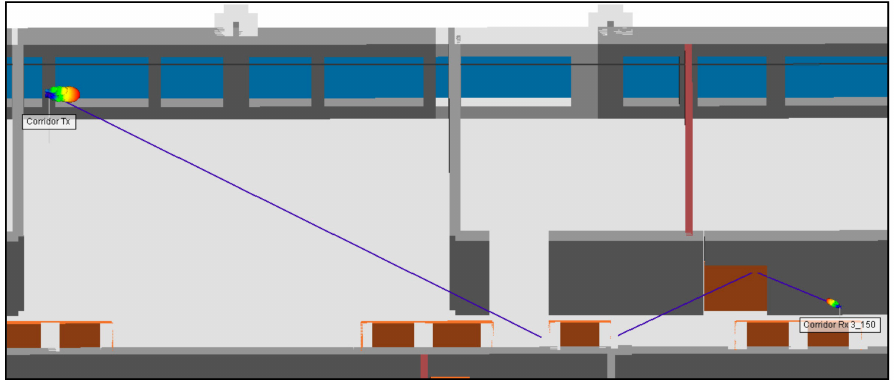
Figure 15. Reflection from two wooden surfaces strongest paths for all Rx3, RSS = − 37.25 dBm.